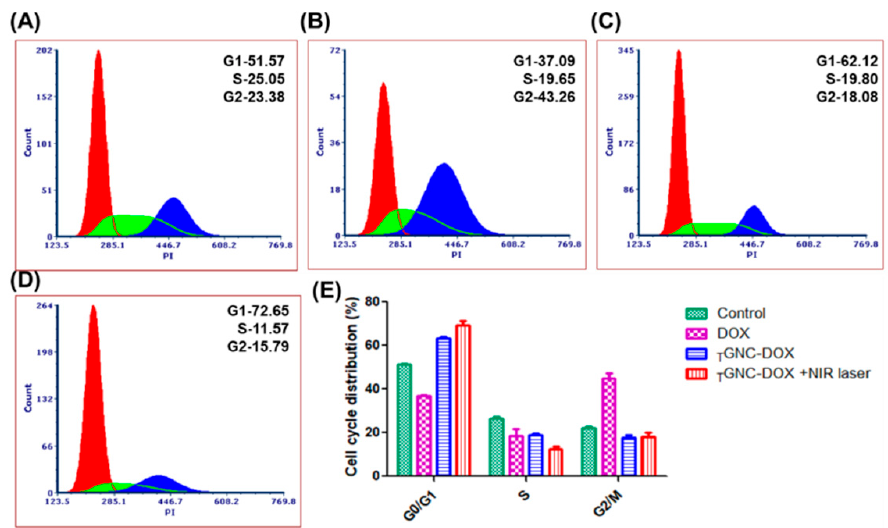
Figure 14. Cell cycle analysis followed by treatment of: ( A ) control; ( B ) DOX; ( C ) T GNC-DOX only; ( D ) T GNC-DOX + NIR laser; and ( E ) bar graph showing percentage cell cycle distribution of different treatment groups ( n = 3).